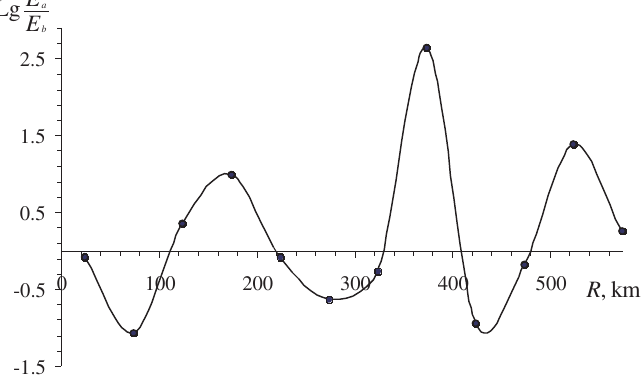
Fig. 5 . The ratio E a / E b of the total seismic energy of earthquakes of the North Tien Shan and adjacent areas occurring after and before 114 MHD-generator start-ups as a function of the distance to location of the MHD- generator on Bishkek test-site. The values E a / E b are plotted on a logarithmic